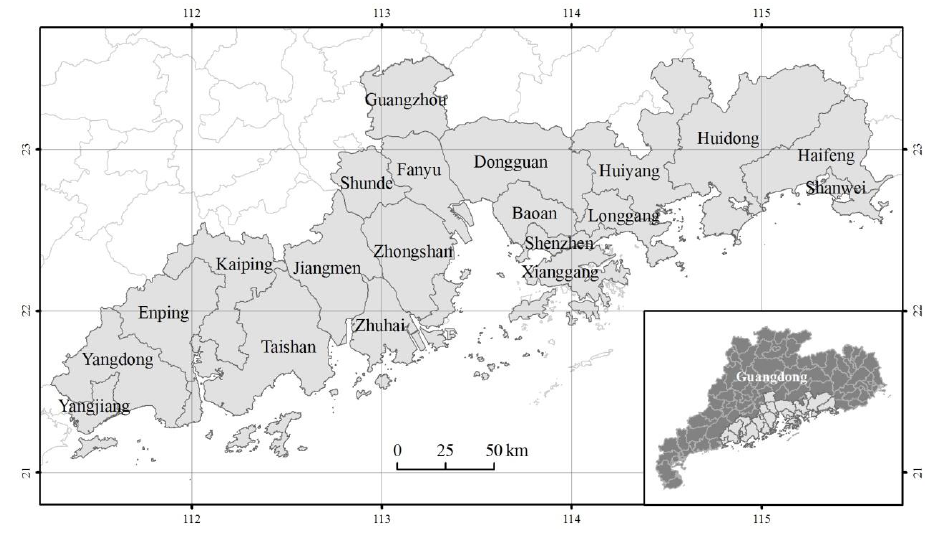
Fig. 1 Study area ranged from Yangjiang to Shanwei in Guangdong Province Fig. 1. Study area ranged from Yangjiang to Shanwei in Guangdong Province. status information to avoid the distortion of double